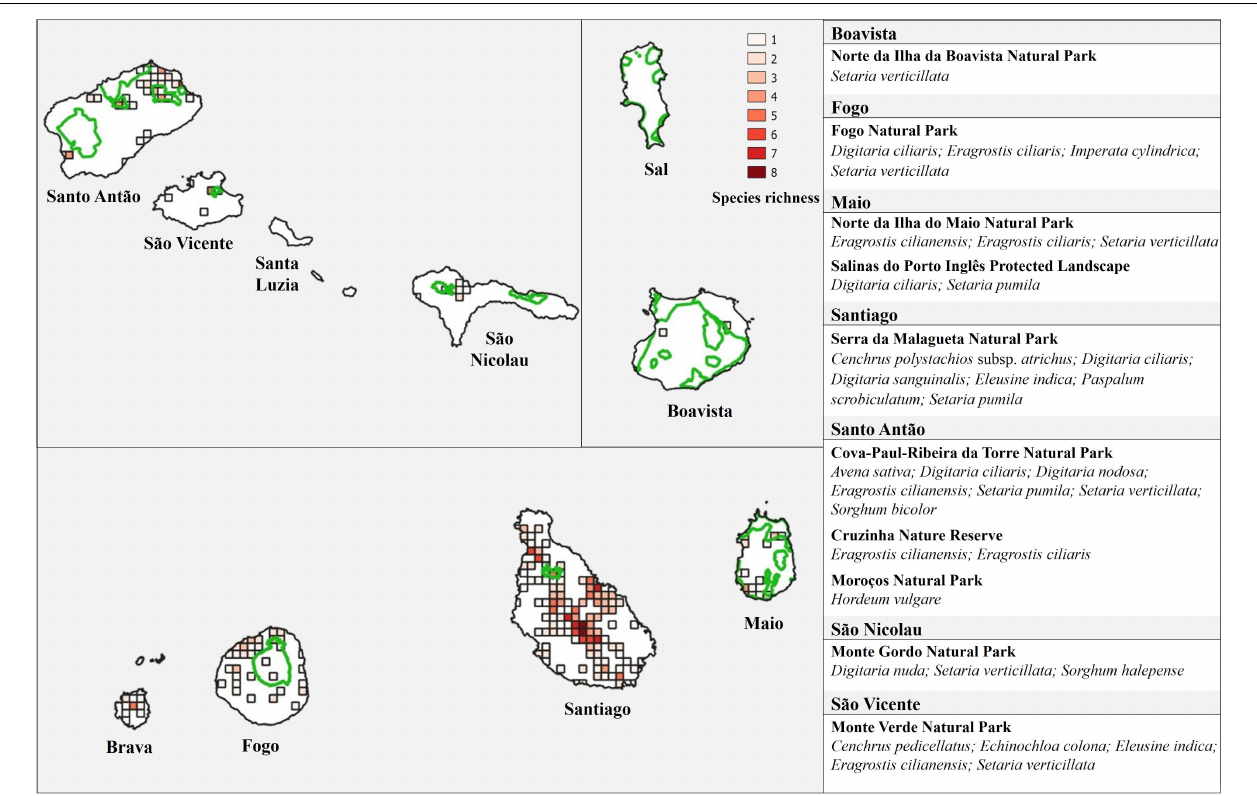
FIGURE 6 | Species richness of the CWR Poaceae species in Cabo Verde Islands, in 2 km × 2 km cells, and network of protected areas (green lines). The CWR taxa occurring in each protected area are listed (right).